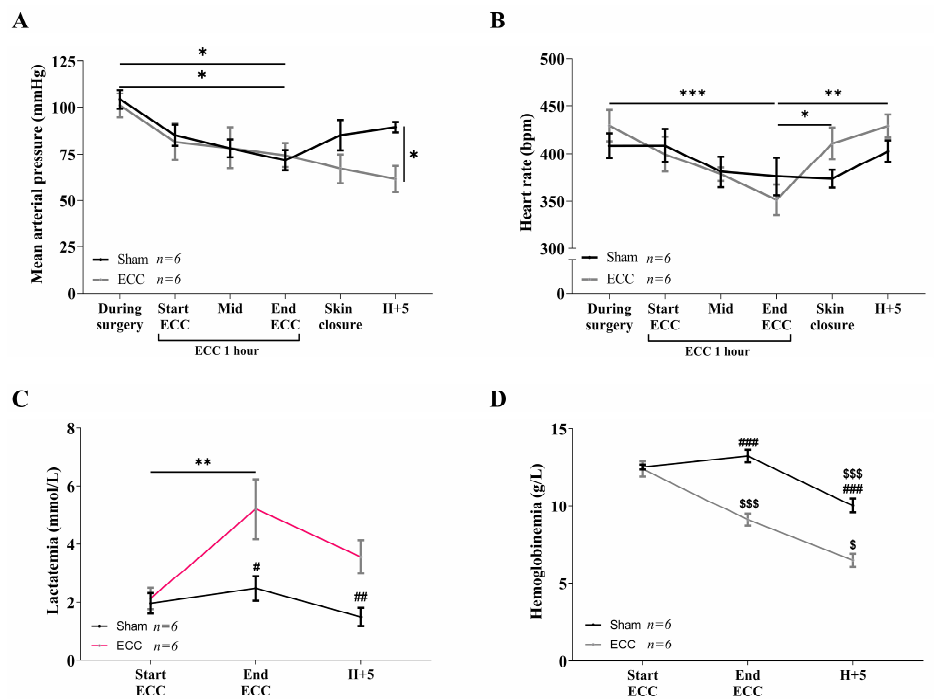
Figure 1. Hemodynamic monitoring, lactatemia, and hemoglobinemia measures in rats over time. The sham group ( n = 6) is represented in black and the ECC group ( n = 6) in grey. The mean arterial pressure (mmHg) ( A ) and heart rate (bpm) ( B ) were monitored during the procedure. Each point (during surgery, start of ECC, mid-ECC, ECC end, skin closure, and H+5) is a mean of 10 min of recording. Lactatemia (mmol/L) ( C ) and hemoglobinemia (g/L) ( D ) were measured from point-of- care tests from whole arterial blood at the start of ECC, at the ECC end, and 5 h postoperatively (H+5). Statistical analyses were performed by a paired two-way ANOVA test with Sidak’s multiple comparisons test. * p < 0.05, ** p < 0.01, *** p < 0.001, # p < 0.05 vs. ECC, ## p < 0.01 vs. ECC, ### p < 0.001 vs. ECC, $ p < 0.05 vs. ECC start, $$$ p < 0.001 vs. ECC start.